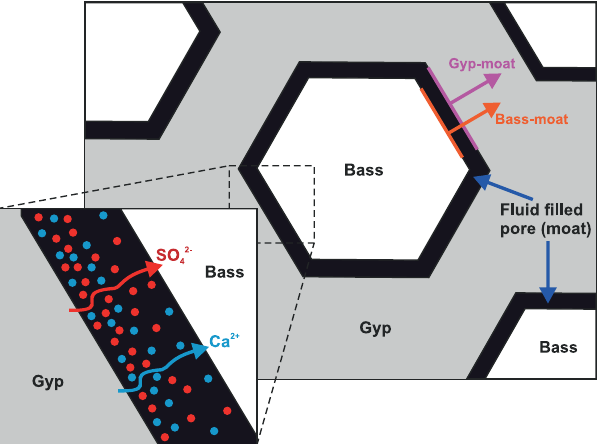
Figure 3. Schematic cartoon of the chemical transport pathways during reaction. For the majority of their growth history bassanite grains grow in relative isolation from nearby grains. Transport of dissolved solutes (Ca 2 + and SO 42 − ) occurs via diffusion across the fluid-filled moats surrounding the growing bassanite grains. Also marked are the two interfaces that were measured in the 2D image analysis (Fig. 4): the bassanite-moat interface and the gypsum-moat interface. As grains grow both interfaces move away from the grain centre and we are able to track how the area inside these interfaces evolves with